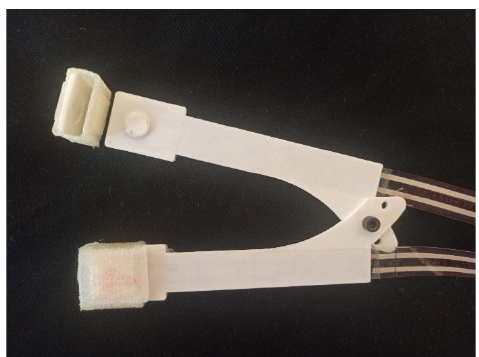
Figure 6. Modified implementation of a bilateral bite force measurement, originally proposed by Weisschircher [9]. The sensors are here embedded and sealed within the 3D-printed housing, and 3D-printed rubber cuffs are inserted over the sensing areas.